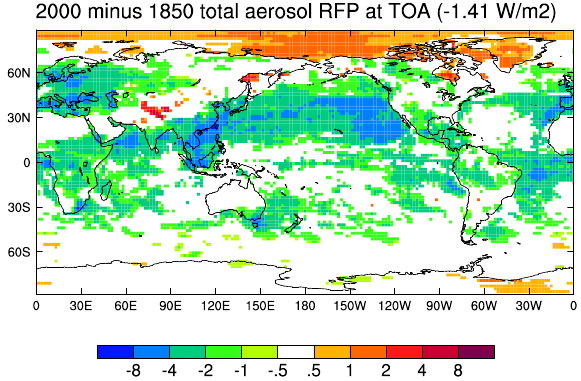
Fig. 2. Anthropogenic aerosol forcing (the difference between 2000 and 1850) in Wm − 2 , calculated as the total aerosol radiative flux perturbation at TOA. Only values significant at 5% are plotted, based on a two-sample